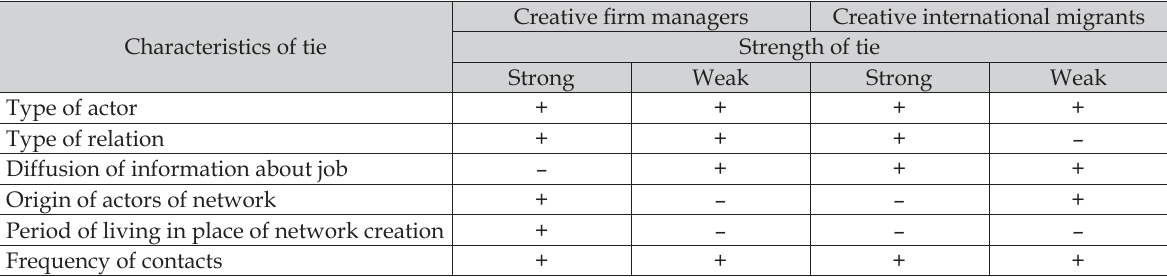
Table 2. Influence of selected characteristics of ties in personal networks of creative-sector workers on the possibility of finding a contract/job.